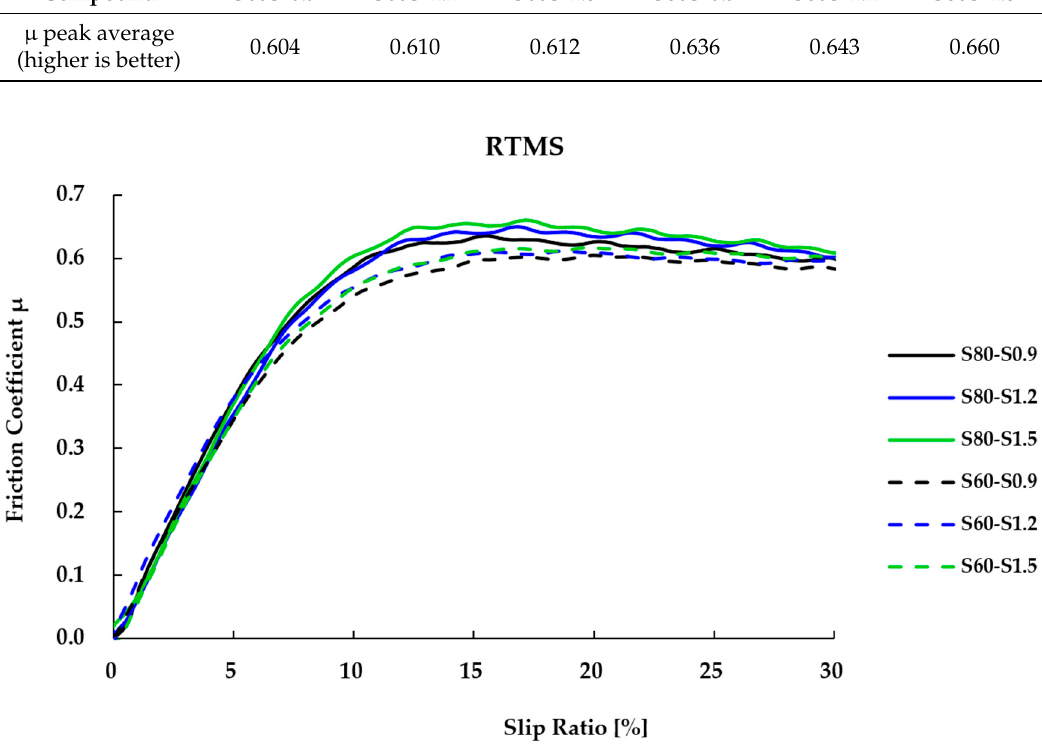
Figure 5. Friction coefficient μ of vulcanizates according to slip ratio.